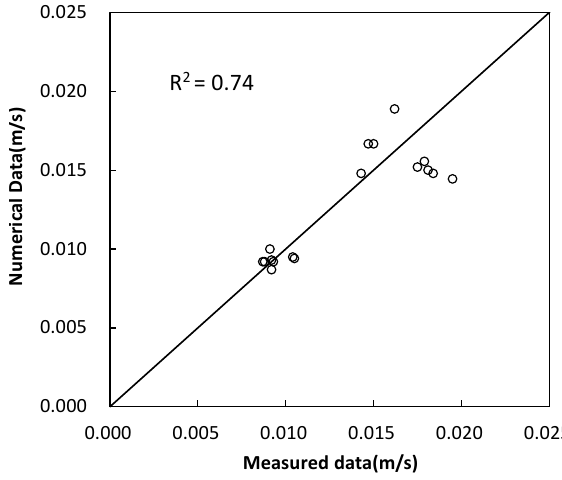
Figure 8. Comparison of the simulations and the observation for